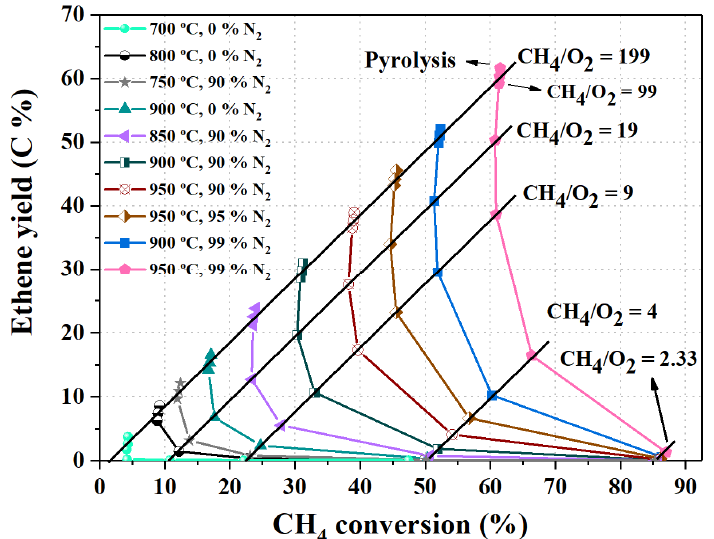
Figure 23. Thermodynamic ethene yield as a function of CH 4 conversion at 1 bar and different conditions of temperature, CH 4 /O 2 feed molar ratio and inert concentration. Feed composition was varied while keeping the total number of mols of reactants constant.